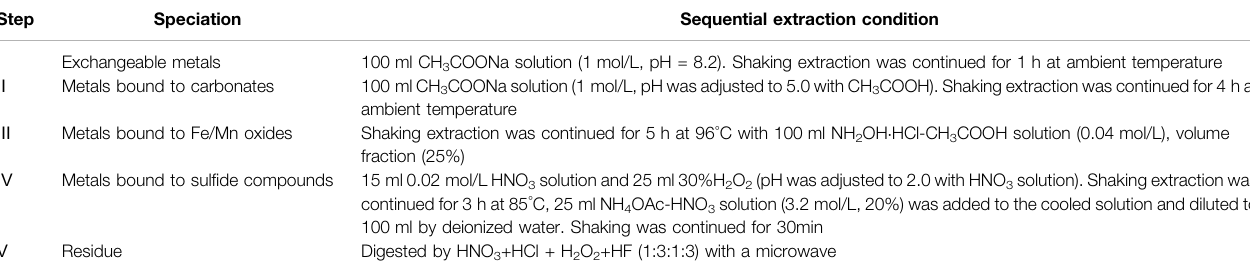
TABLE 3 | Modi fi ed Tessier sequential extraction methods (Tan et al., 1997; Wei et al.,